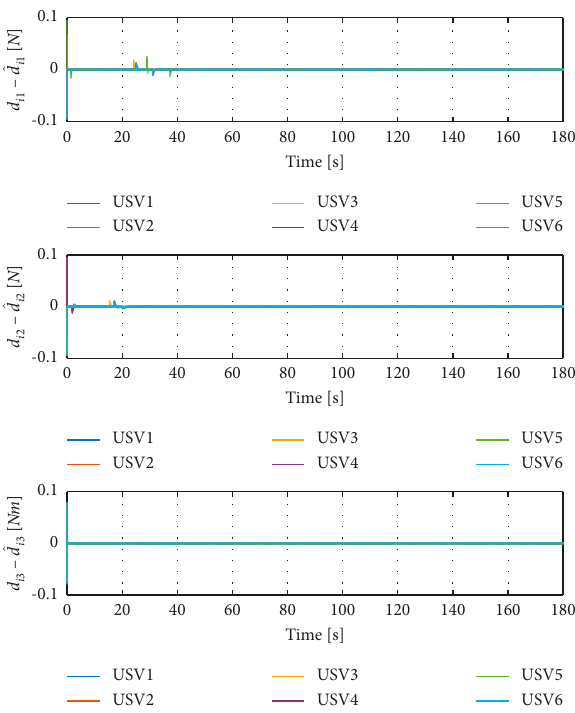
Figure 8: The disturbance error ( 􏽥 d